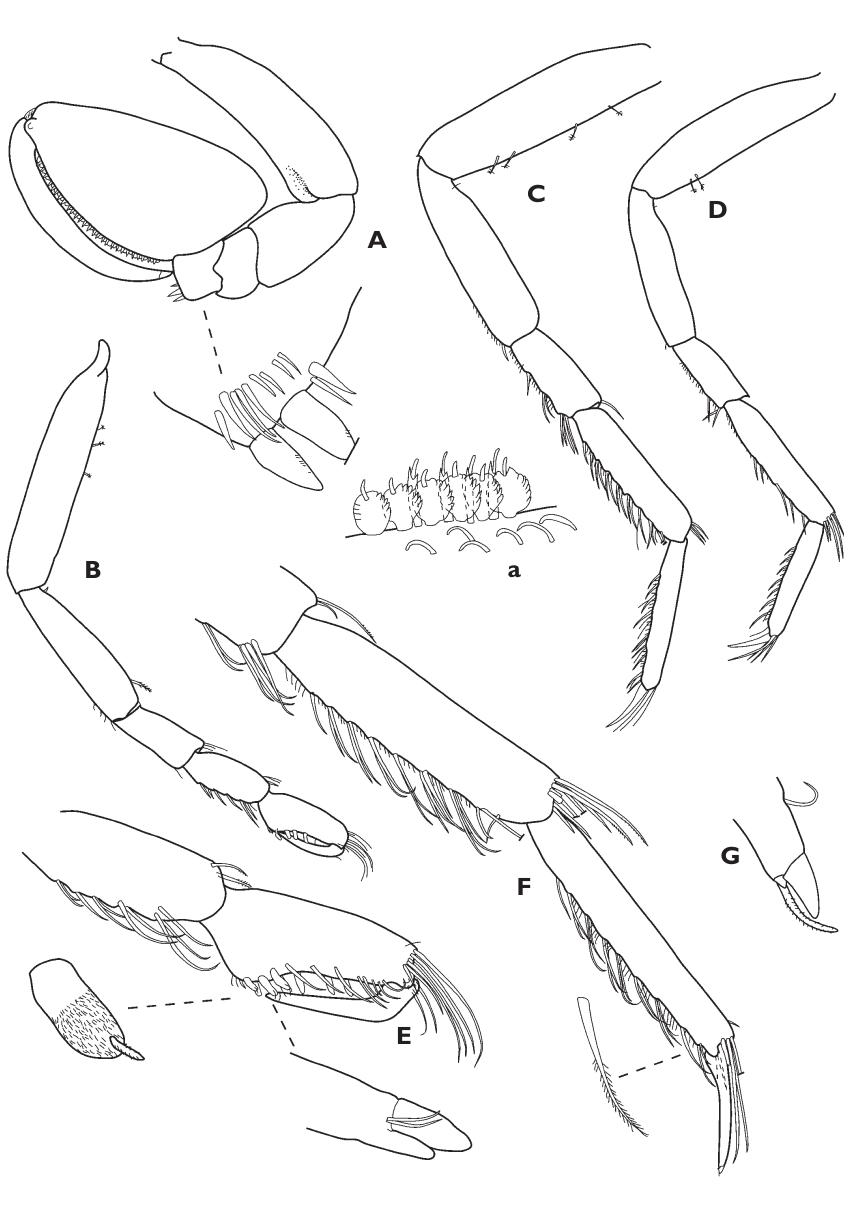
Figure 17. Myopiarolis norfanz sp. n. Paratype ♂ 10.7 mm. A–D pereopods 1, 2, 6 and 7 respectively a detail of pereopod 1 propodal palm setae E pereopod 2 carpus and propodus and detail of dactylus apex F pereopod 6 carpus and propodus G pereopod 7, dactylus